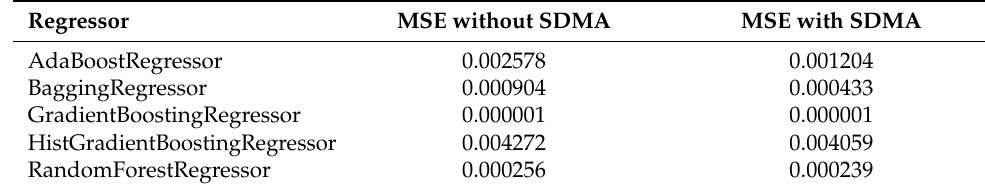
Table 2. MSE for individual regressors with and without SDMA as an extra feature.